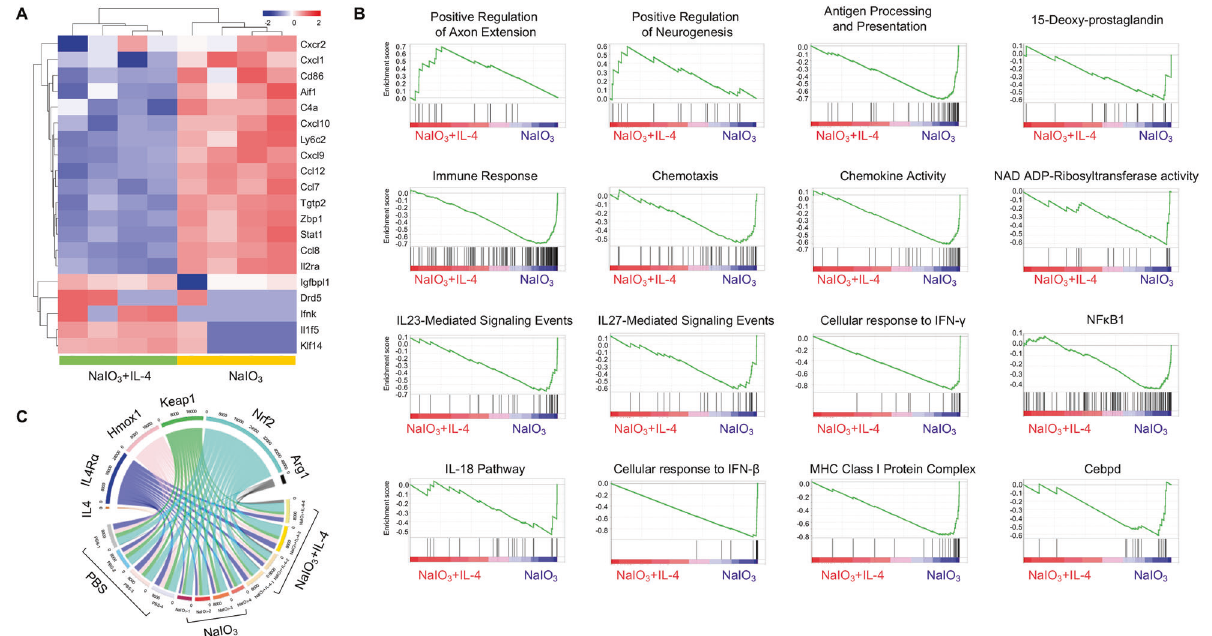
Fig. 3 The transcriptional changes of NaIO 3 -induced RPE sheet. A Heatmap showing differentially expressed in fl ammation-related genes in NaIO 3 mice with and without IL-4 treatment. The pro-in fl ammatory genes such as Cxcr2 , Cxcl1 , Cxcl10 , Stat1 , Ccl8 , etc were down-regulated in the IL-4-treated group, while the anti-in fl ammatory genes, including Il1f5 , Klf14 , Drd5 , Ifnk , etc were upregulated. B GSEA analysis revealed signi fi cantly enriched gene sets such as axon extension and neurogenesis in the IL-4 group, and the enriched gene sets, including the in fl ammation and oxidative stress-related gene sets in the NaIO 3 -RPE without IL-4. n = 3, FDR value <0.25. C The enrichment analysis of IL-4R α and anti-oxidative genes such as Nrf2 , Hmox1 , and Arg1 in different groups were presented by circos plot. The thickness and color of the ribbons correlated to the genes